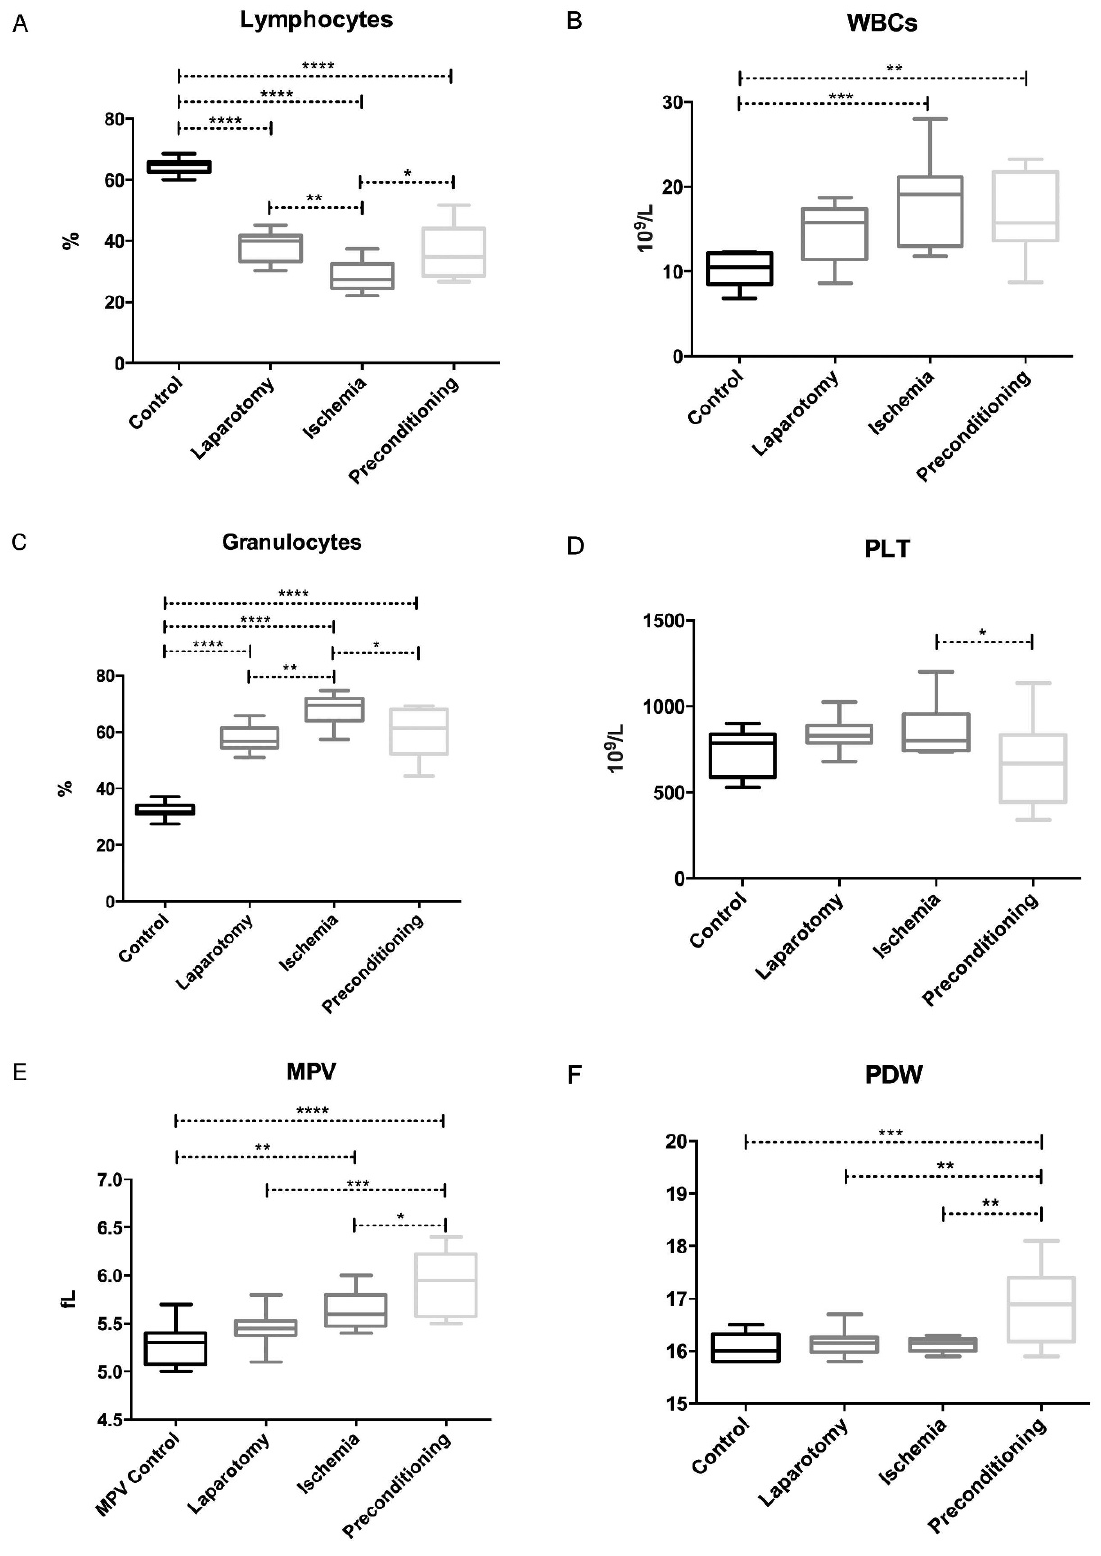
Figure 2 - Distribution of the hematimetric parameters in the four experimental groups. (A) Lymphocyte count, (B) WBC count (C) Granulocyte count, (D) Platelet count, (E) MPV and (F) PDW. (*** p , 0.001; ** p , 0.001 to 0.01; * p , 0.01 to 0.05).